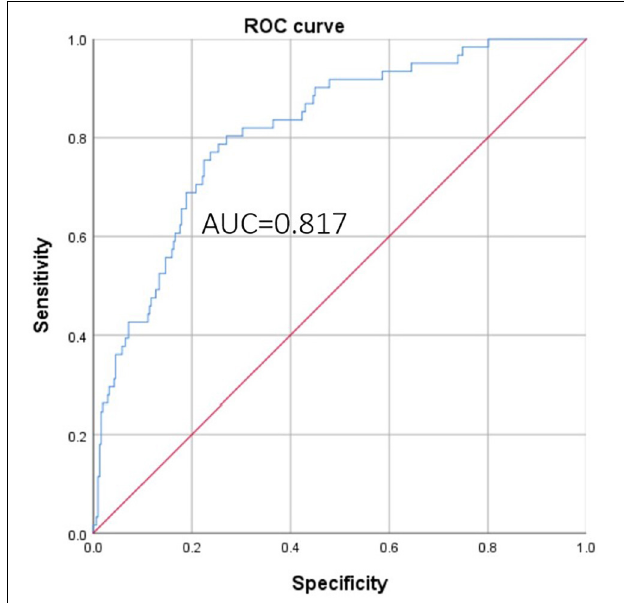
FIGURE 3 | ROC curve of the model for predicting massive bleeding.